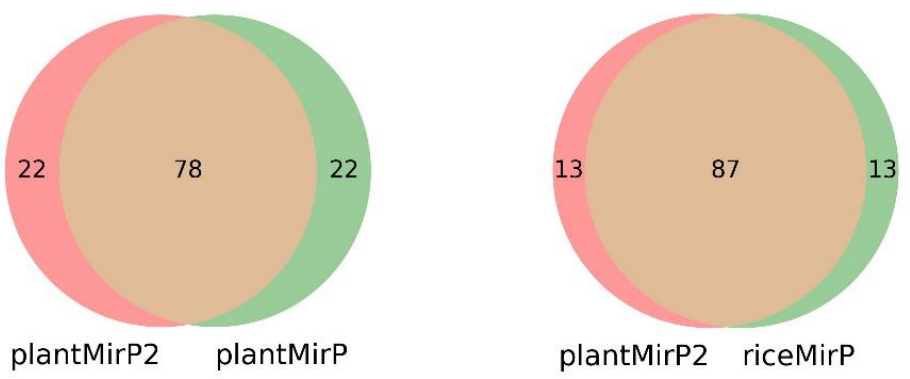
Figure 8. Venn diagram results for the top predictions of plantMirP2, plantMirP and riceMirP based on the miRbase (release 21) training dataset and the miRbase (release 22.1) testing dataset.